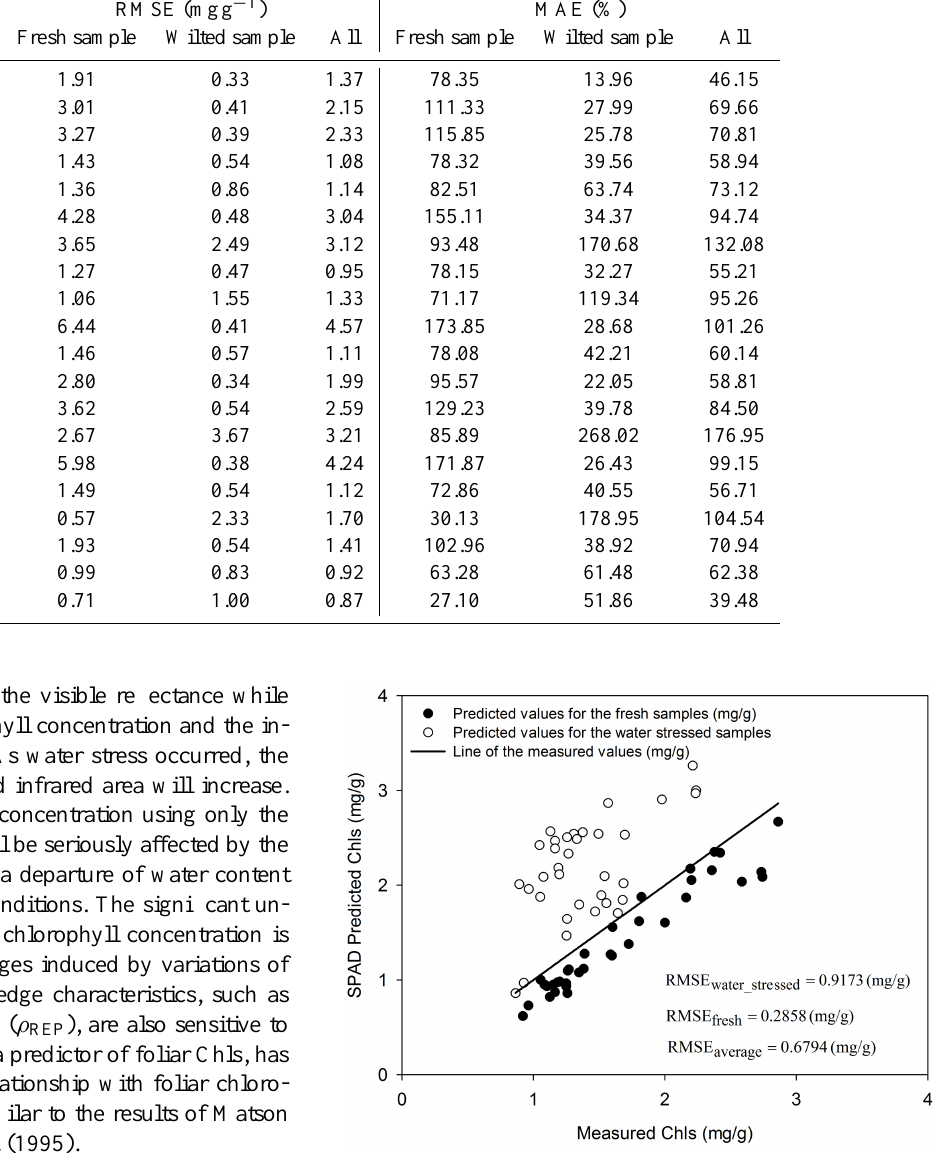
Figure 9. Evaluation of the prediction accuracy of the SPAD chloro- phyll regression model. Number of data points is 70. For testing fresh samples, the estimation error is 0.2858mgg − 1 ; for testing samples which are water stressed, the error is 0.9173mgg − 1 . Aver- age error is 0.6794mgg − 1 for all of the testing data